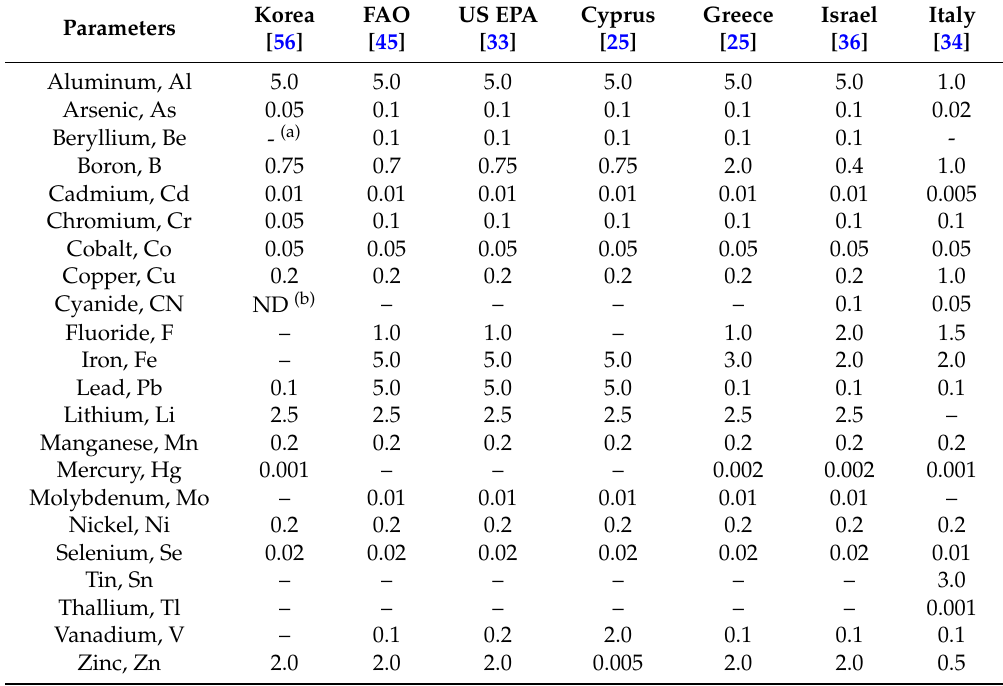
Table 4. Comparison of recommended maximum concentrations of trace elements in irrigation